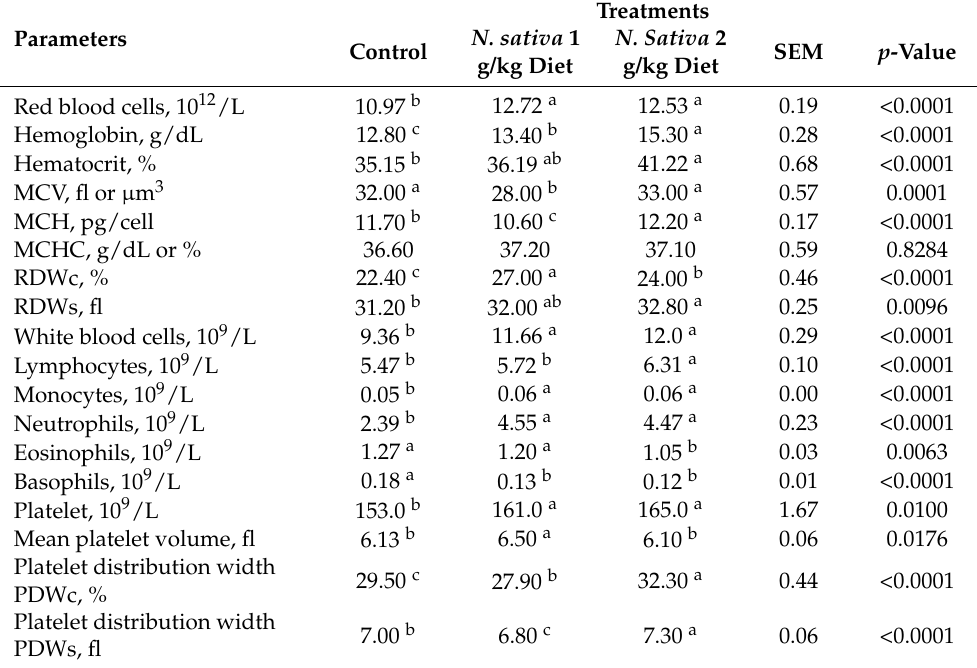
Table 4. Effects of N. sativa (10.0 and 20 g/kg diet) on blood indices of Ardi goats in the subtropics.